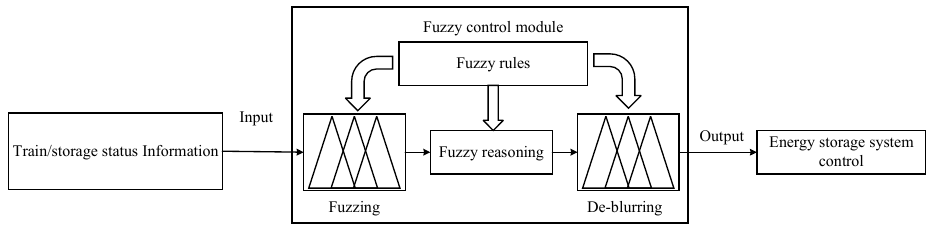
Figure 35. Block diagram of fuzzy control of energy storage.